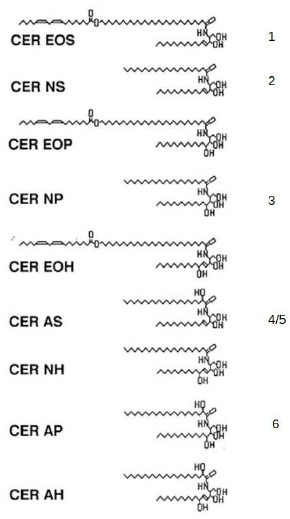
Figure 2. Ceramide structures from porcine and human stratum corneum [5]. The numbers (1–6) on the right indicate ceramides from porcine stratum corneum, while human ceramides are indicated on the left in the nomenclature of Motta et al. [12]. The porcine ceramide designated as 4/5 separates into two separate bands. The more mobile fraction contains mostly 20 ‐ through 28 ‐ carbon α‐ hydroxyacids amide ‐ linked to sphingosine and dihydrosphingosine bases. The less mobile fraction is mostly α‐ hydroxy palmitic acid amide ‐ linked to the same bases. In the human CER AS, there is an α‐ hydroxyacid ‐ containing component with a more uniform chain length distribution.